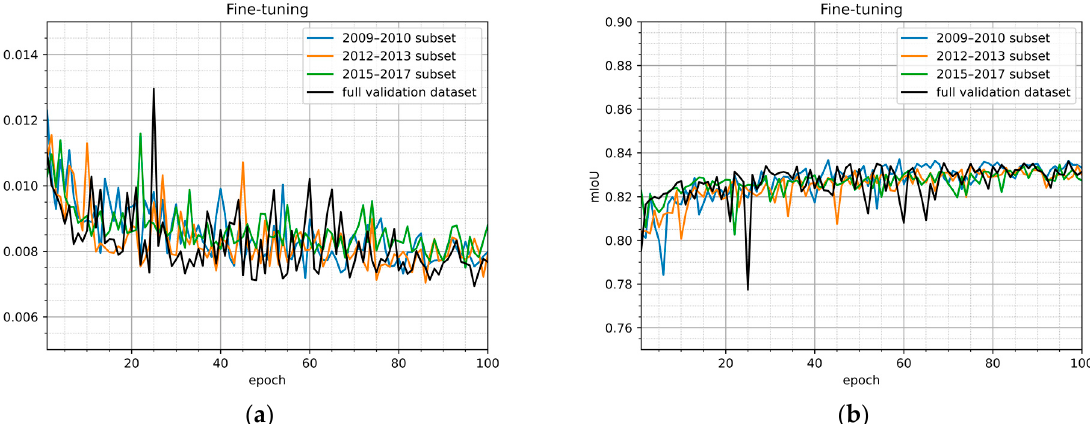
Figure 8. Evaluation metrics (focal loss ( a ) and mIoU ( b )) for fine-tuning validation set and its subsets during the fine-tune learning.